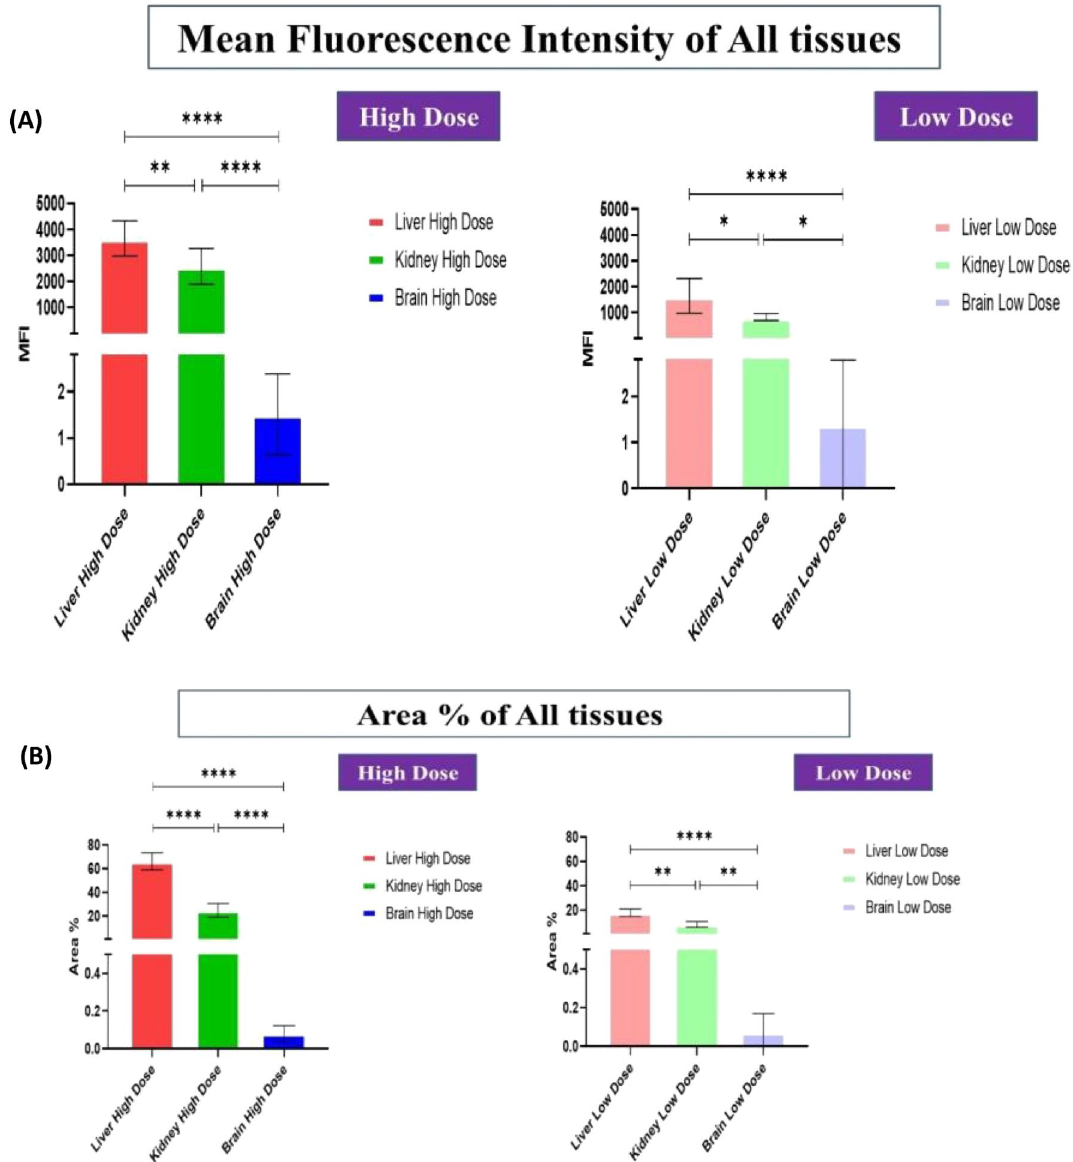
Figure 11. Comparison between the MFI ( A ) and the mean area % ( B ) of the studied tissues. Data were expressed as mean ± SE; Significance: N.S.: no significance *p ≤ 0.05, **p ≤ 0.01, ***p ≤ 0.001, ****p ≤ (ATCC 25177) with 98.4%. The antibacterial mode of action of Au-NPs was discussed by Mohamed et al. 35 who reported that gold nanoparticles have a bactericidal effect through bacterial cell wall penetration, aggregation and vacuoles formation inside the cytoplasm. In line with the current findings, Zawrah et al. 36 reported that fluconazole-coated Au-NPs have shown improved antifungal efficacy against Aspergillus niger , Candida albi‑ cans , and Aspergillus flavus 36 . Avan et al. 37 revealed that Au-NPs with 13 nm diameter have a broad range of antimicrobial activity against multiple microorganisms at various doses. Previous researches have indicated that plant-mediated metal nanoparticles play an important role in medication administration and may be utilized to combat a wide range of bacteria due to their effective antimicrobial characteristics 38–40 . Abdel-Aziz et al. 38 studied the in vitro anti-mycobacterial activity of Au-NPs (11–17.5 nm diameters) and stated that the MIC value reached 1.95 µg/mL. However, Govindaraju et al. 39 revealed that the sensitive strain of M. tuberculosis showed lower MIC value upon treatment with Au-NPs reached 10 μg/mL compared to rifampicin resistant strains (zero inhibition). On the contrary, Singh et al. 40 reported that Au-NPs had no anti-mycobacterium activity at different concentrations up to 100 µg/mL. Au-NPs of various shapes and sizes with desirable characteristics were produced using chemical synthesis technologies, allowing for multimodal cancer treatment with extended anti-tumor action 41 . Huang et al. 42 dem- onstrated that the ultra-small Au-NPs had marvelous advantages in tumor penetration in vivo. In recent study, Brazilian red propolis was used for synthesis of Au-NPs which exhibited potent anticancer activity with IC50